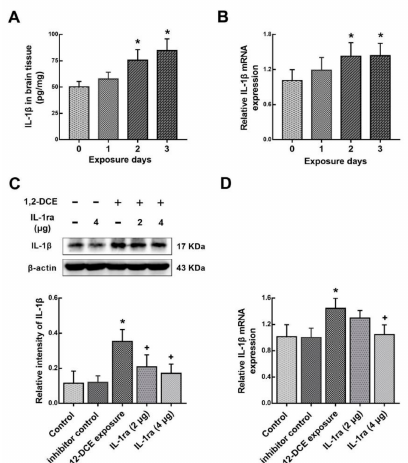
Figure 7. Changes of IL-1 β along with the exposure days and involvement of IL-1ra in IL-1 β expression in 1,2-DCE-intoxicated mice. ( A ) IL-1 β expression levels in the brain tissues measured by ELISA. ( B , D ) Measurement of mRNA levels by real-time RT-PCR. The mRNA levels of IL-1 β were normalized to GAPDH and presented as fold change of the control group. ( C ) Images represent Western blot, and graphs show the densitometric quantitation of IL-1 β , which were normalized to the intensity of β -actin. Data expressed as mean ± SD are the results of five independent experiments and analyzed by one-way ANOVA. Significant di ff erence is defined as p < 0.05, and *, vs. control group; + , vs. 1,2-DCE poisoned group; # vs. low dose intervention group.